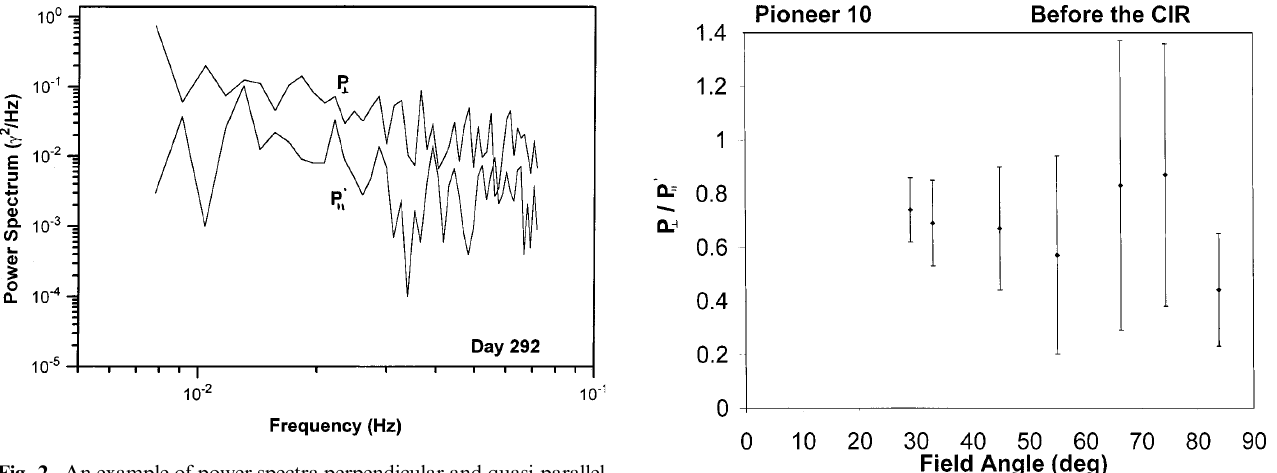
Fig. 3. Ratio P ? = P 0 as a function of the angle of the mean magnetic k field for the interval before the CIR